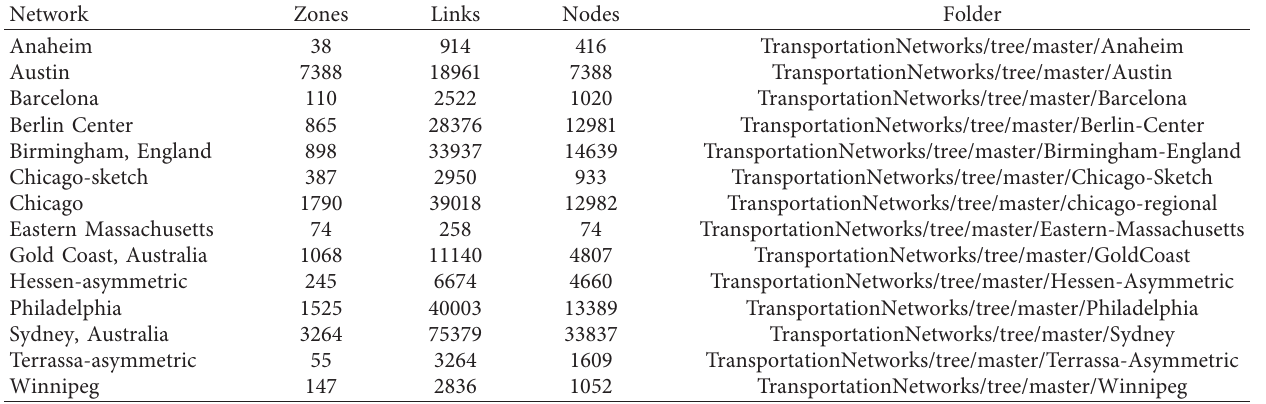
Table 6: An overview of selected transportation networks for ODAM research at https://github.com/bstabler/TransportationNetworks. Network